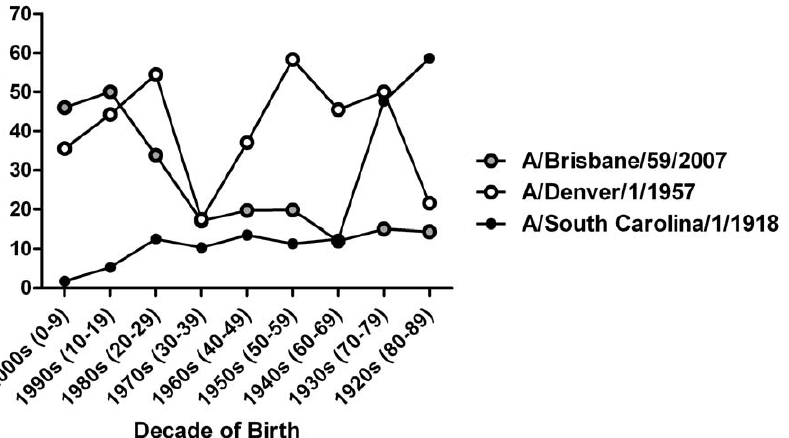
Figure 3. Seropositive samples for historical influenza A H1N1 strains (A/Brisbane/59/2007, Denver/1/1957 and A/South Carolina/1/ 1918).